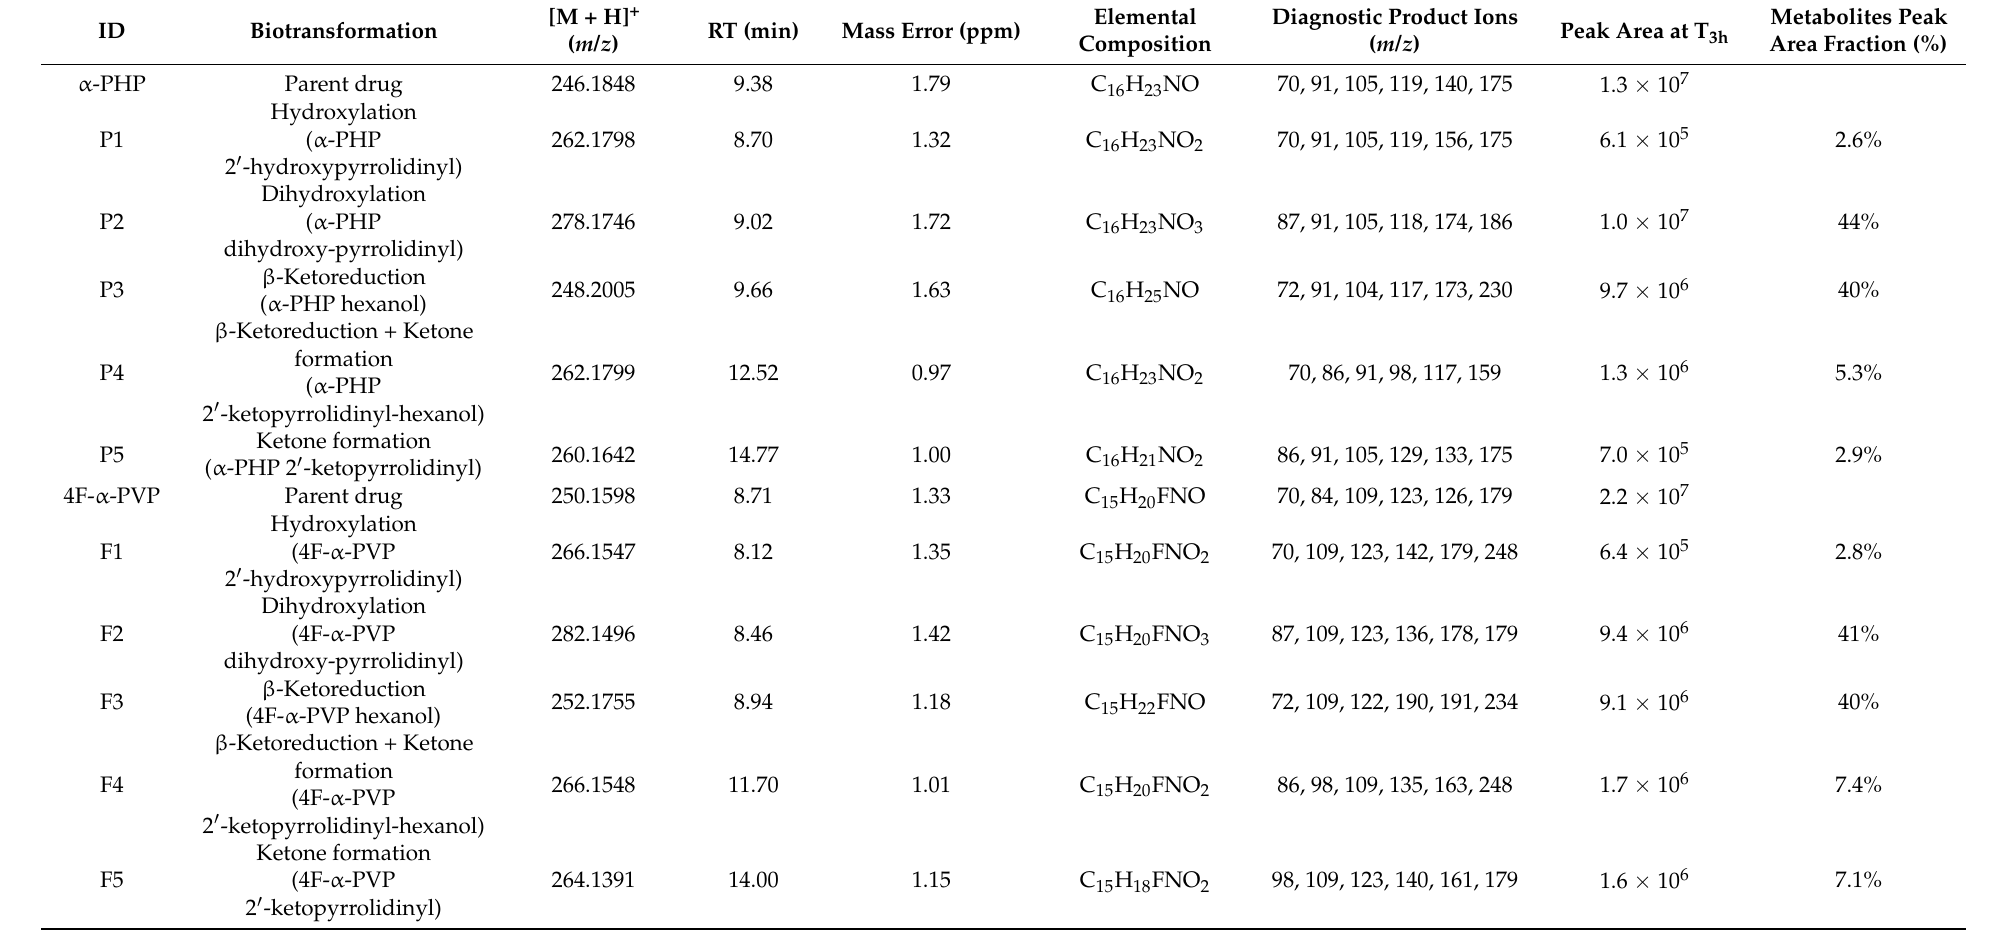
Table 1. Accurate mass molecular ion, retention time (RT), elemental composition, nominal mass for diagnostic product ions, MS peak areas, and α -PHP and 4F- α -PVP metabolites peak area fraction (sum = 95 and 98%, respectively) in hepatocyte incubations. Peak area for α -PHP and 4F- α -PVP at T 0h were 6.1 × 10 7 and 7.5 × 10 7 , respectively. Metabolites are listed by ascending RT. MS, mass spectrometry; ND, not detected.